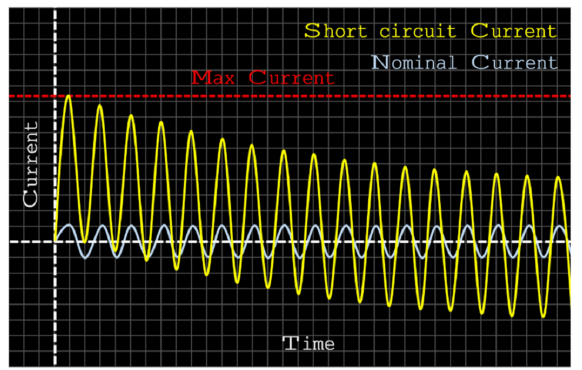
Figure 5. Characteristic curve of the short-circuit